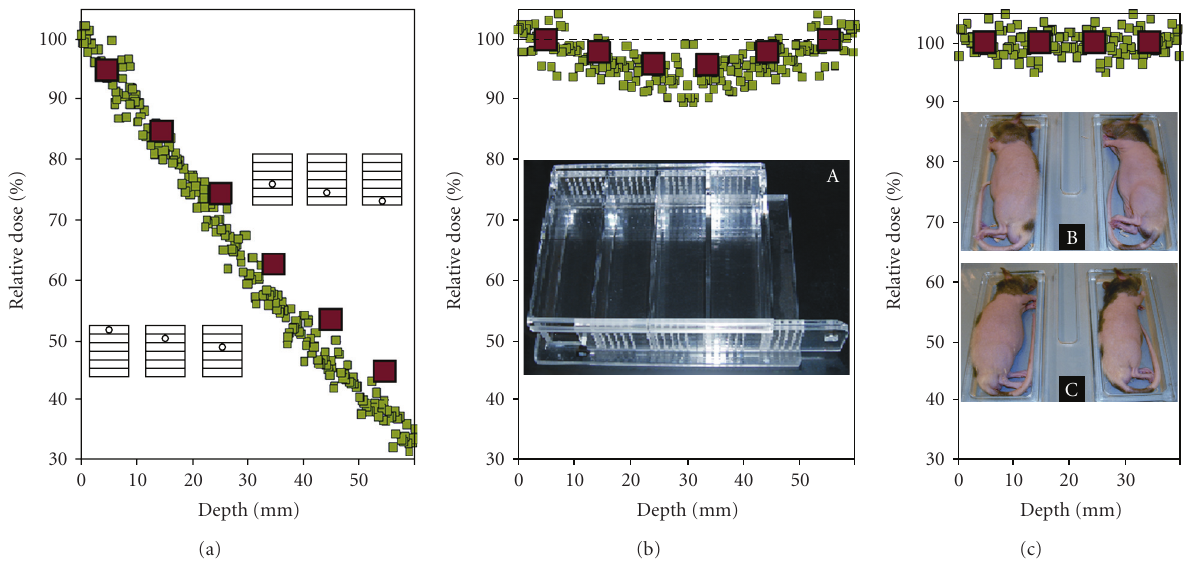
Figure 1: WBI dose variation in phantoms. Dose distribution along the depth of 6cm ((a), (b)) and 4cm (c) water equivalent phantom for Monte Carlo simulation of the X-ray photons passage through matter (green) and dose evaluation using a set of water equivalent plate (1 × 5 × 5cm 3 ) phantoms phantoms (red) for single (a) and double side ((b), (c)) radiation exposure is presented. The curves have been normalized to 100% on the surface of phantoms. Corresponding sets of phantoms with noted position of Ionization Chamber are demonstrated (a). Common (inset A) and new designed (insets B and C) cages with positions of rats during double side irradiation are shown.